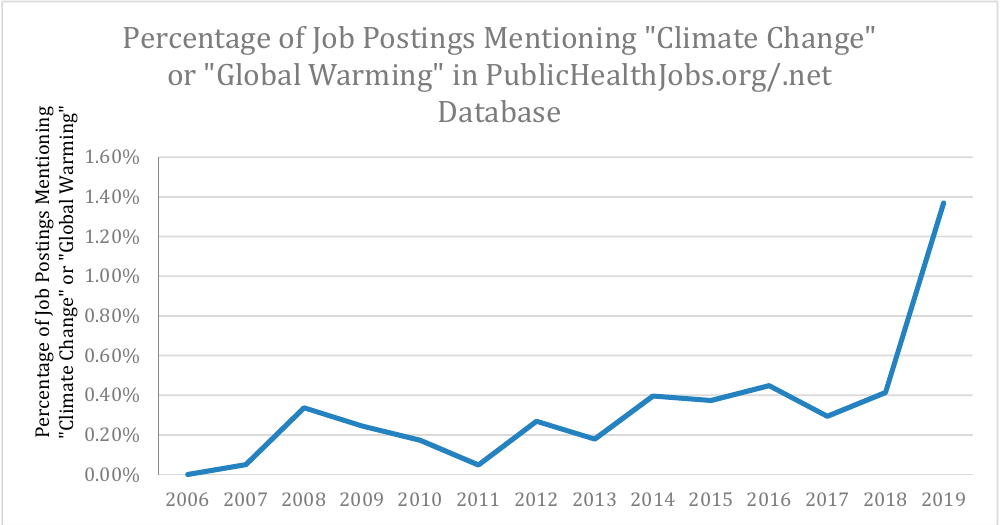
Figure 1. Percent of job postings mentioning “Climate Change” or “Global Warming” in the PublicHealthJobs.org database.